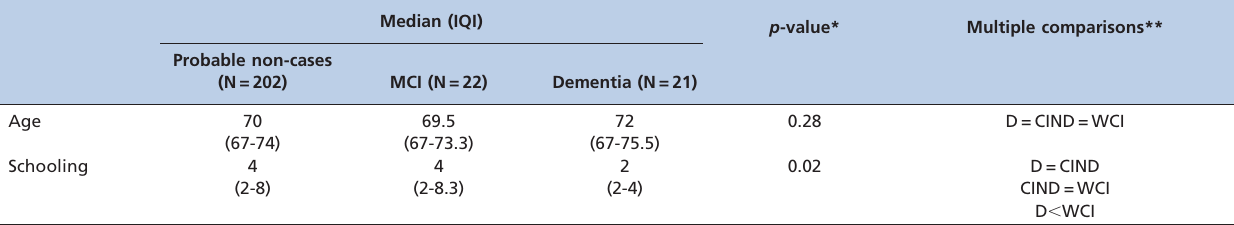
Table 1 - Median, interquartile interval, and comparisons considering age and schooling in the different groups. Median (IQI) p -value*